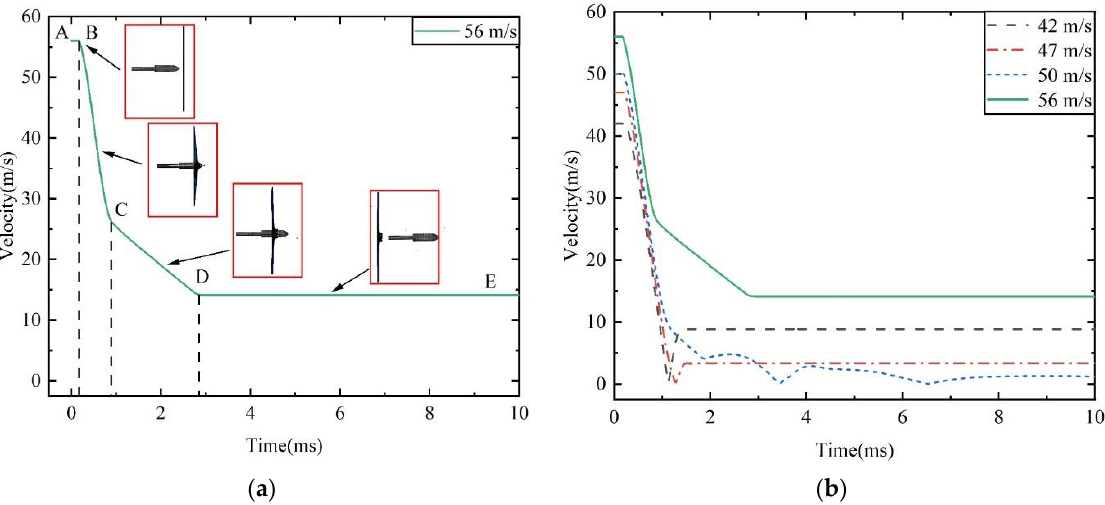
Figure 4. Velocity evolution curve. ( a ) Velocity evolution at 56 m/s of the initial velocity, and ( b ) velocity evolution at 42, 47, 50 and 56 m/s of initial velocities.